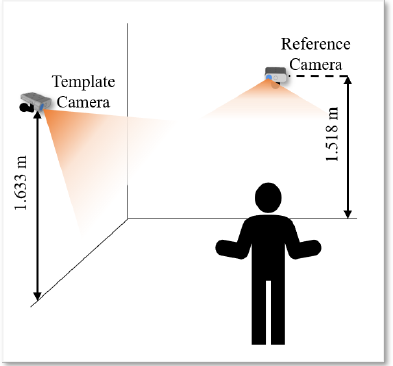
Figure 6. Depiction of the experimental setup considering two Azure Kinects.